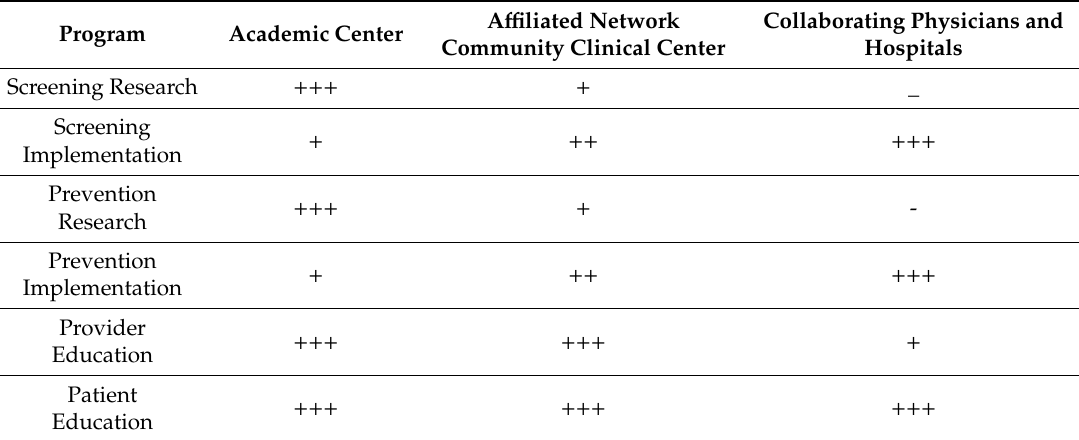
Table 1. Sites for Lung Cancer Screening and